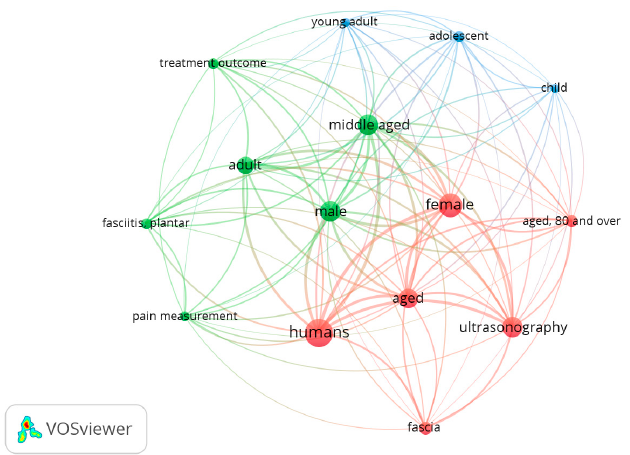
Figure 9. Visualization of keywords for ultrasound examination and fascia.